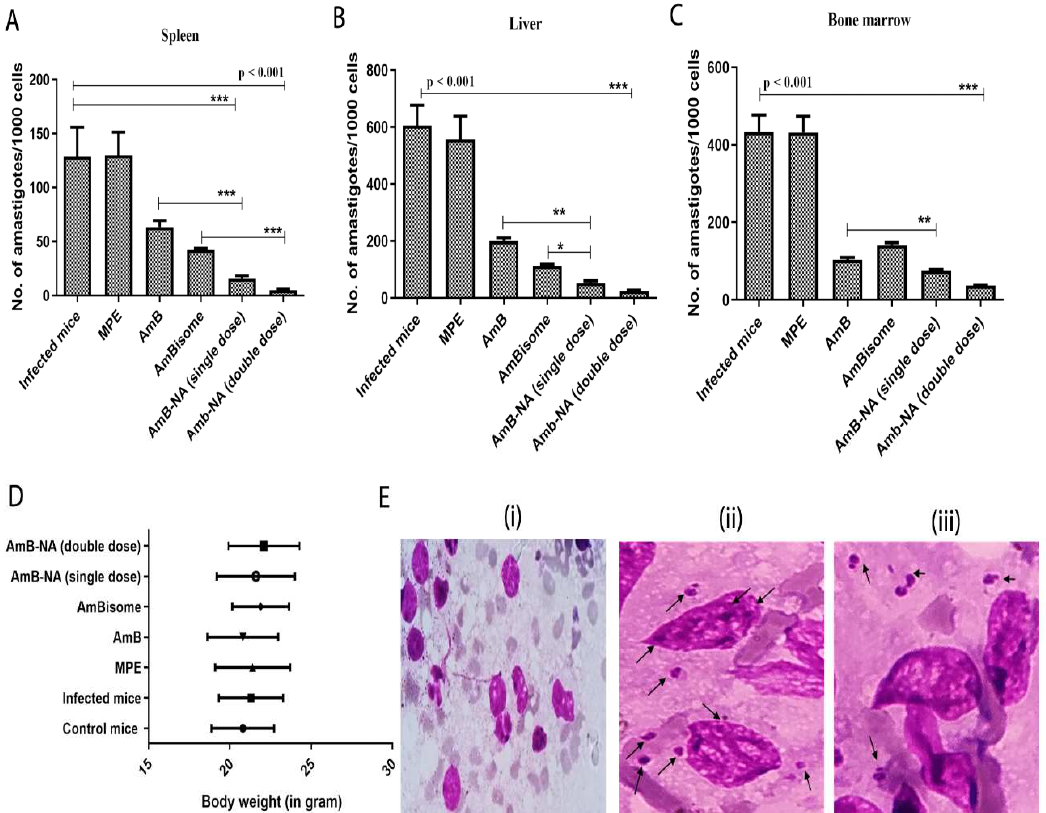
Figure 8. As-synthesized AmB-NA treatment resulted in successful clearance of the in vivo parasite burden. The treatment with AmB-NA resulted in the killing of the L. donovani systemic infection present in the experimental mice’s organs such as the spleen, liver, bone marrow, etc. Infected mice with no AmB treatment were considered as controls. The parasite burden in the spleen ( A ), liver ( B ), and bone marrow ( C ) was determined microscopically (Giemsa-stained cell smear) and expressed as no. of amastigotes/1000 cells. Data represented means ± SE for mice per group and are representative of three independent experiments with similar results. * p < 0.05, ** p < 0.01, *** p < 0.001, ( D ) The relative body weight of the experimental mice before and after drug administration. ( E ) Giemsa-stained uninfected ( i ), L. donovani -infected ( ii ) and L. donovani infected AmB-NA treated cells ( iii ). The arrows are showing the Ld bodies. Data represent the means ± SE for six animals per group. Results correspond to one of the three similar